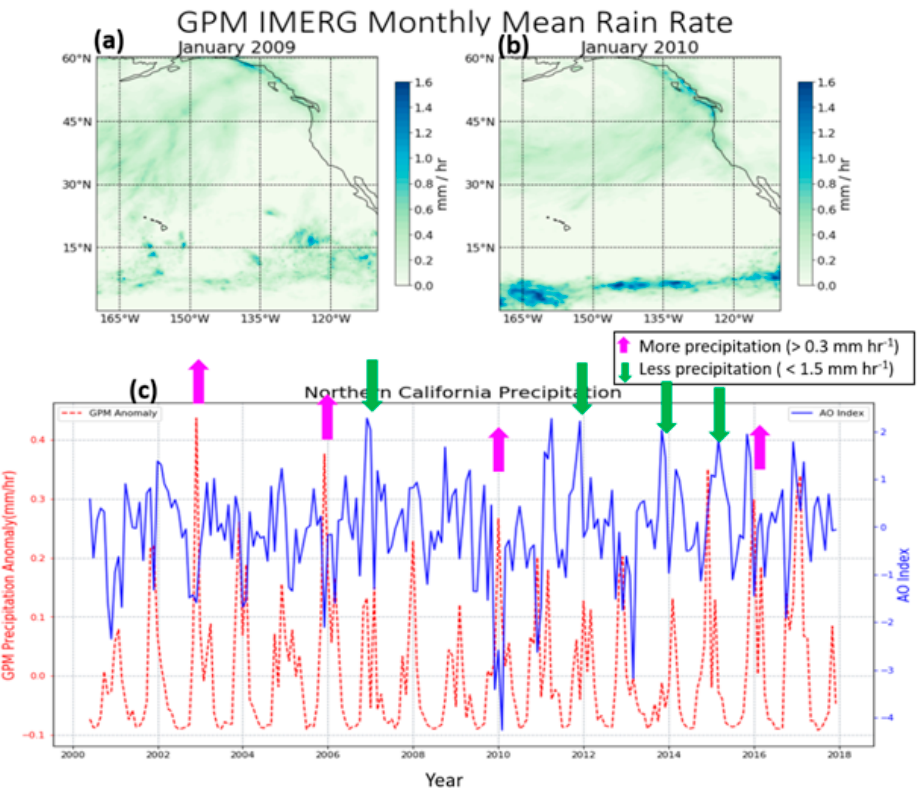
Figure 2. IMERG Precipitation during ( a ) January 2009 and ( b ) January 2010. ( a , b ) correspond to positive AO months and negative AO months, respectively. ( c ) Time series of monthly GPM precipitation and AO index. Precipitation data were calculated by taking the average over the entire northern CA area [122–124° W and 36.5–42° N].